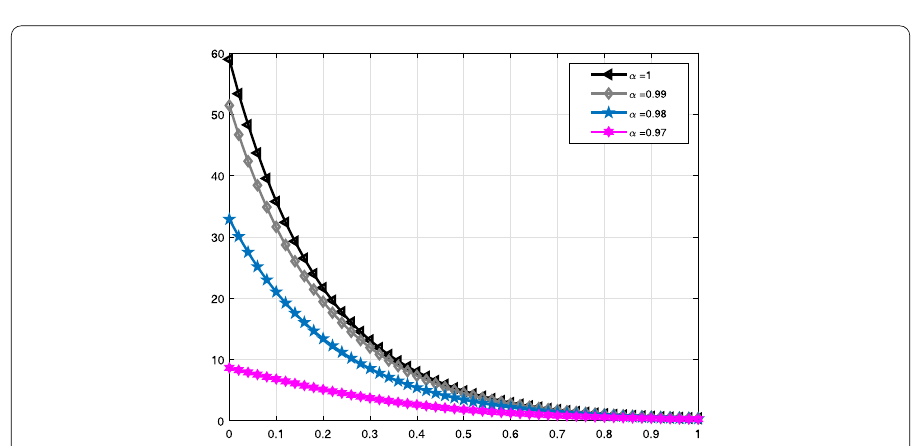
Figure 11 Comparative analysis with conformable derivative for V e ( t